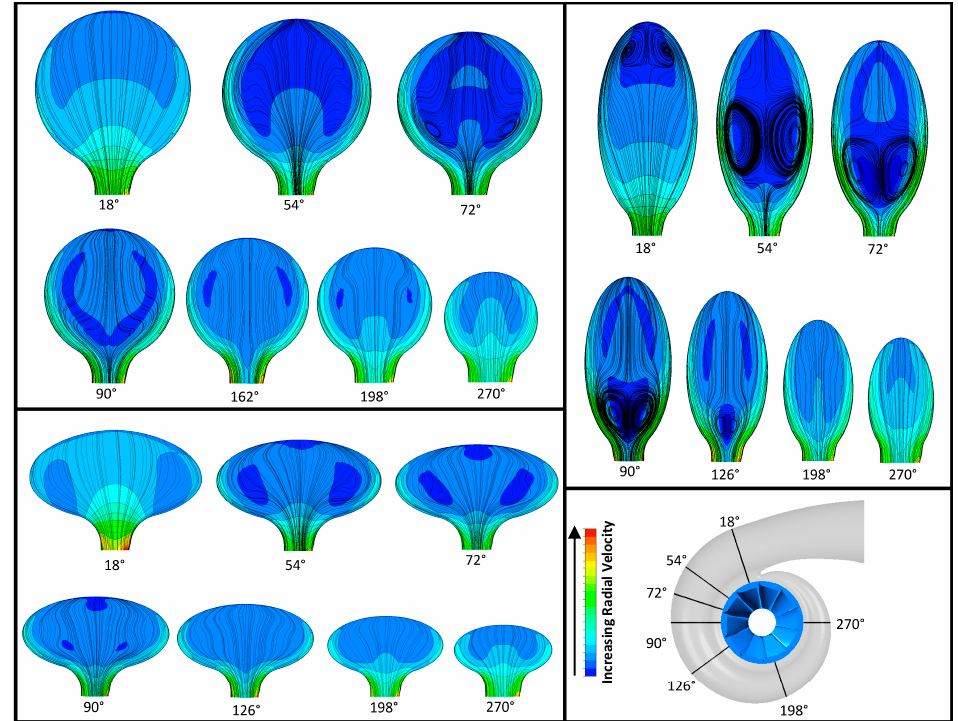
Figure 17. Surface streamlines at planes around the turbine volute and contours of radial velocity at 40 Hz minimum incidence running point.